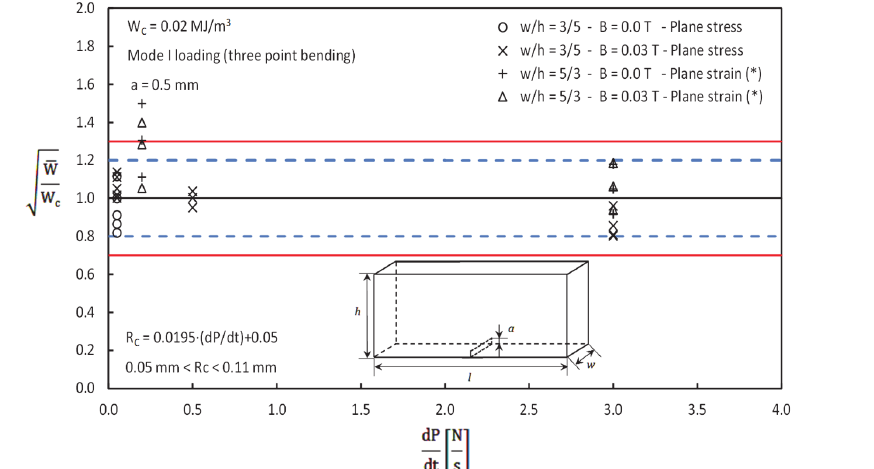
Figure 3: Mean fracture loads as a function of the loading-rate and the magnetic field